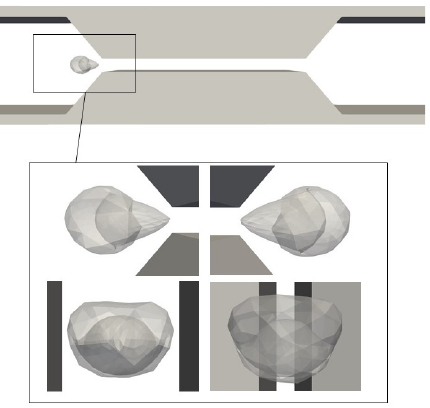
Fig. 2. Unnatural behaviour of the cell in narrow channel. Closer look from top, bottom, back and front view.